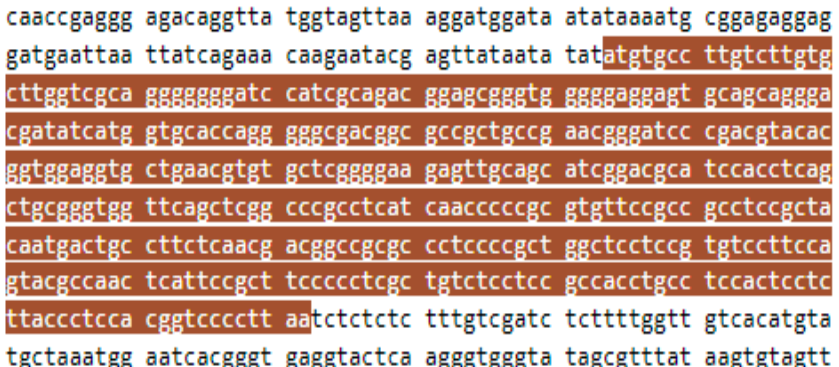
Figure 6. The coding sequence of TPD1-like gene (XM_026801684.1) is highlighted.